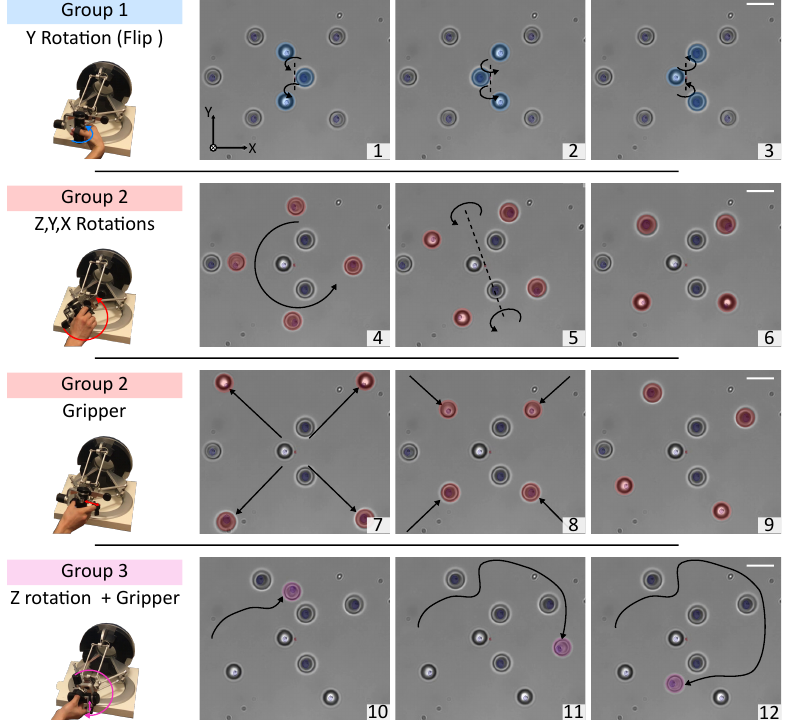
Figure 2. Example of 3D teleoperation using three groups of traps. The operation is a succession of four different tasks demonstrating the system’s capabilities. The first task (1, 2 and 3) is a flip around the y-axis of three micro-beads. The second task (4, 5 and 6) shows the 3D control of four micro-beads. The third task (7, 8 and 9) presents the ‘radial’ operating mode of the gripper. Finally, the last task (Picture 10, 11 and 12) presents the travel of one micro-bead around all the others. Scale bars are 5